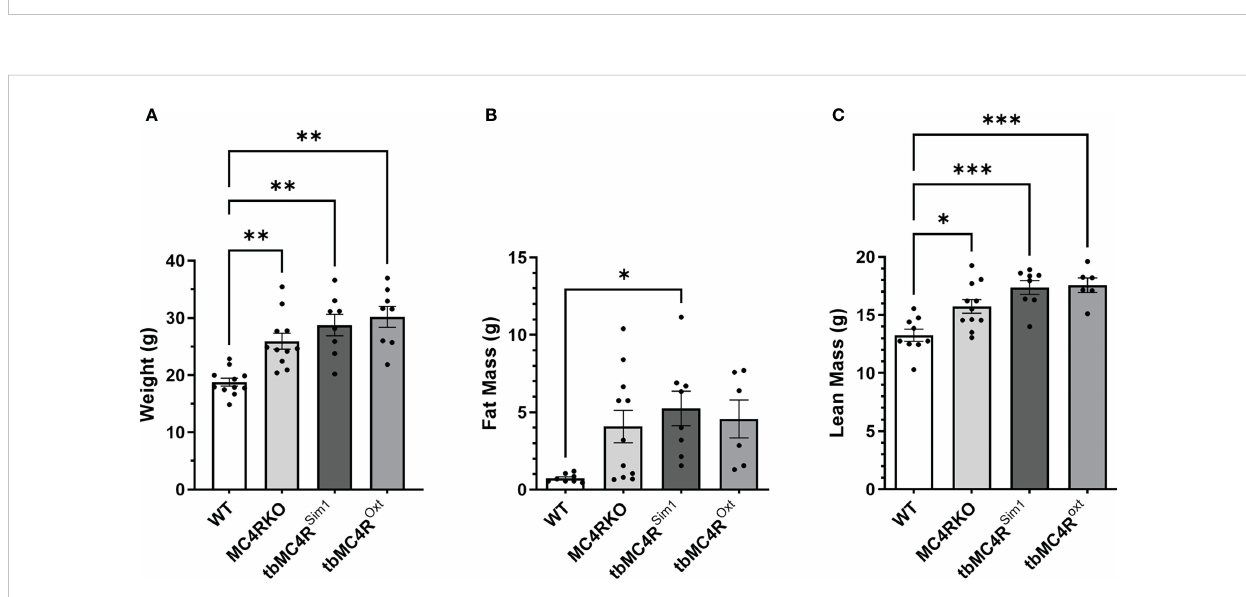
FIGURE 10 Body composition of mice lacking MC4R. Comparison of the (A) body weight, (B) fat mass, (C) lean mass measured by NMR of cre control (n=8-11), MC4RKO (n=9-11), tbMC4R Sim1 (n=8), and tbMC4R Oxt (n=6-9) groups at two months of age. One-way ANOVA with Sidak ’ s multiple comparisons test was used for graphs C and E. Brown-Forsythe and Welch ANOVA tests with Dunnett ’ s T3 multiple comparisons test was used for graphs A and B. Graph A, WT vs MC4RKO (p=0.003), tbMC4R Sim1 (p=0.005), and tbMC4R Oxt (p=0.002). Graph B, WT vs tbMC4R Sim1 (p=0.025). Graph C, WT